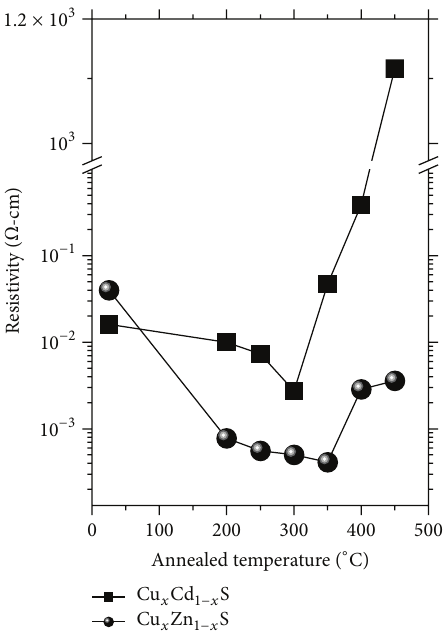
Figure 5: Resistivity values as a function of the annealing tempera- ture.